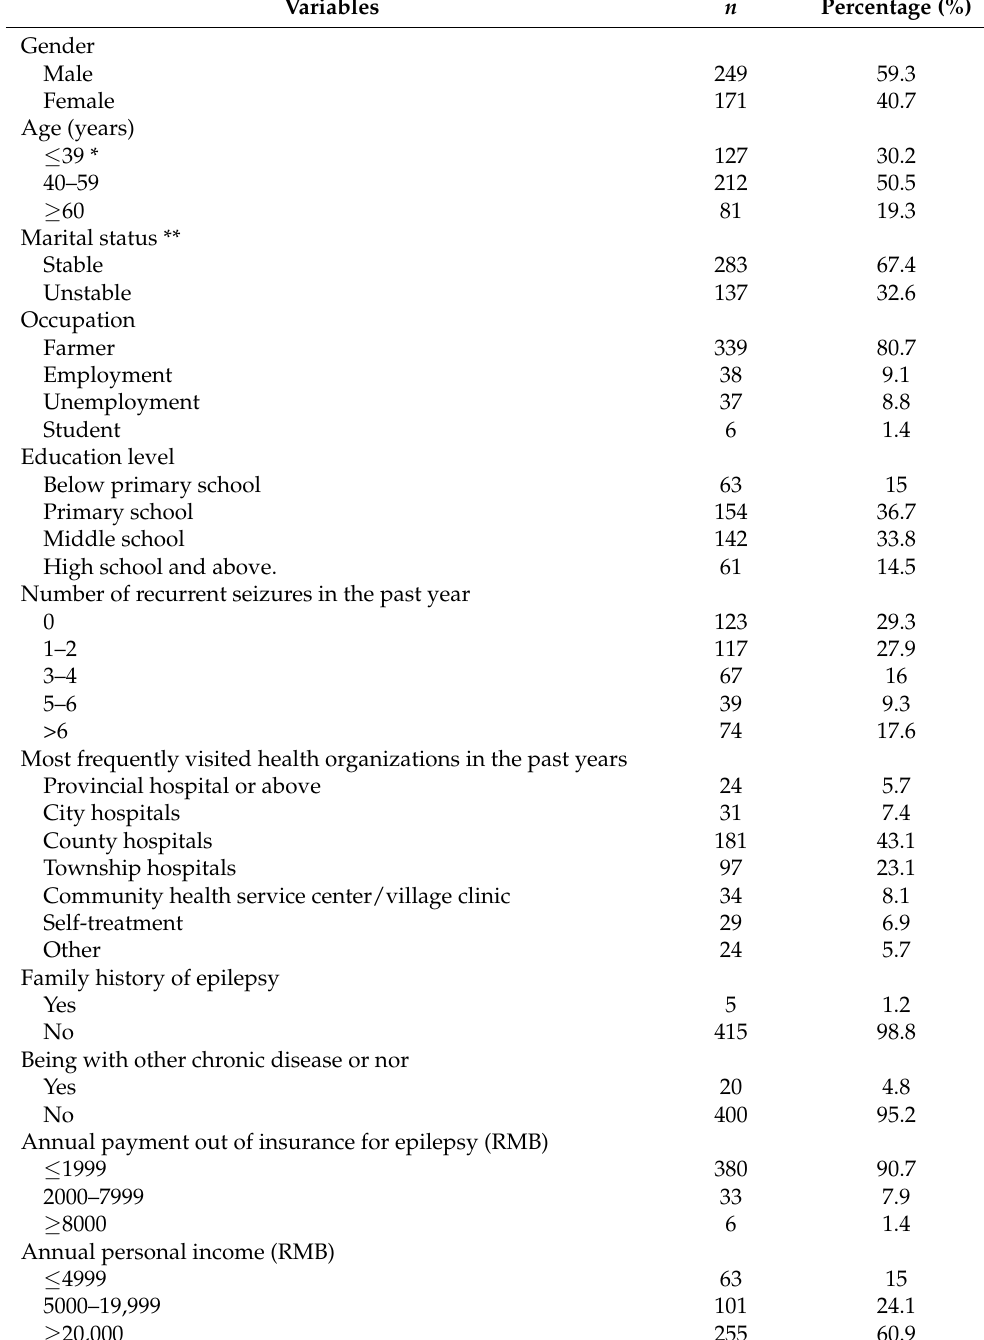
Table 1. Characteristic of the study